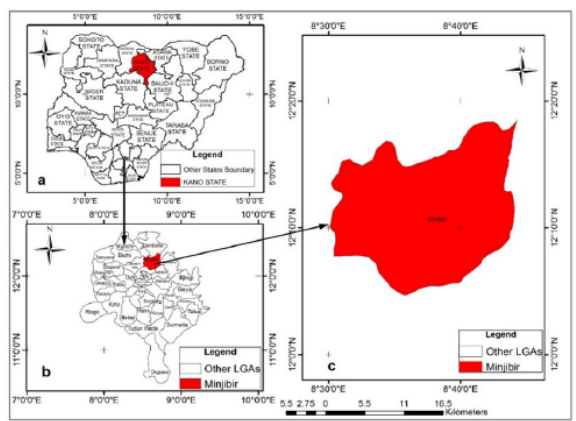
Figure 1: Study Area Map, a) Location of Kano State in Nigeria, b) Location of Minjibir LGA in Kano state, c) Minjibir LGA